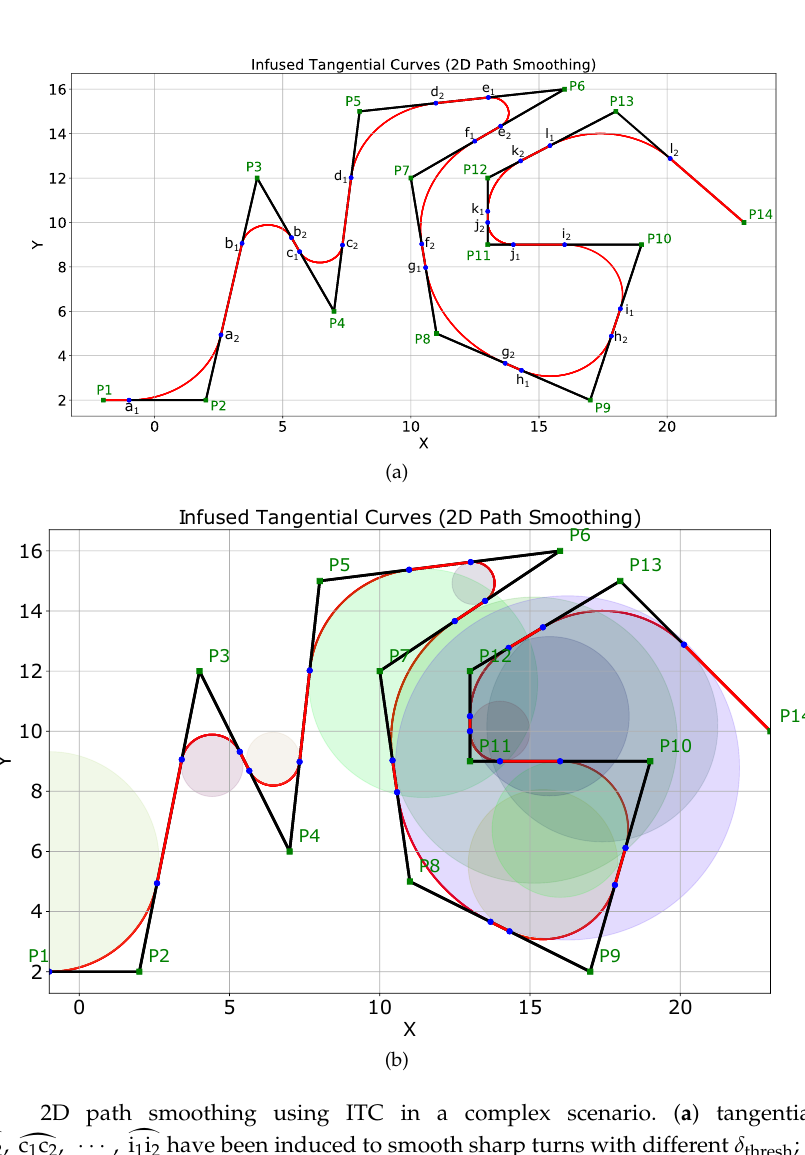
Figure 8. 2D path smoothing using ITC in a complex scenario. ( a ) tangential curves ¯ a 1 a 2 , ¯ b 1 b 2 , ˜ c 1 c 2 , · · · , ˆ i 1 i 2 have been induced to smooth sharp turns with different δ thresh ; ( b ) visual representation of the different curves and their curvatures.